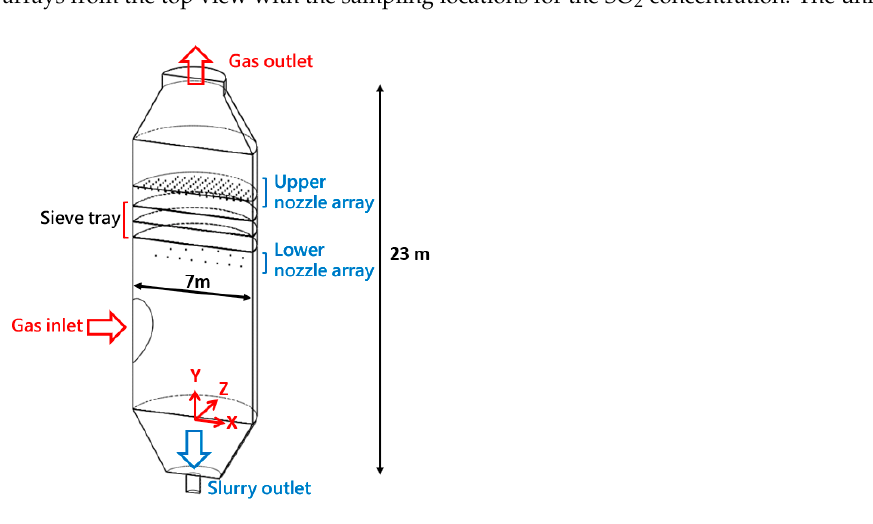
Figure 3. This figure displays ( a ) details of the small-scale FGD tower and ( b ) the layout of the nozzle arrays from the top view with the sampling locations for the SO 2 concentration. The unit is meter.